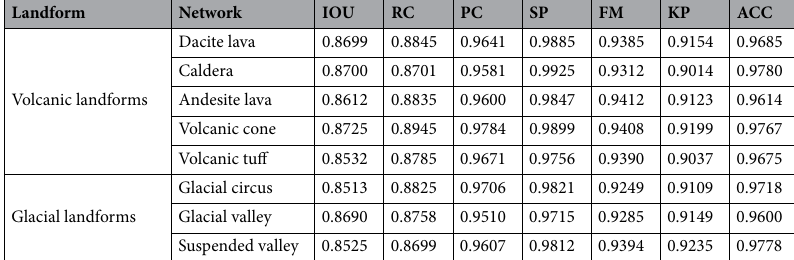
Table 9. Results of evaluation indexes for volcanic and glacial landforms.